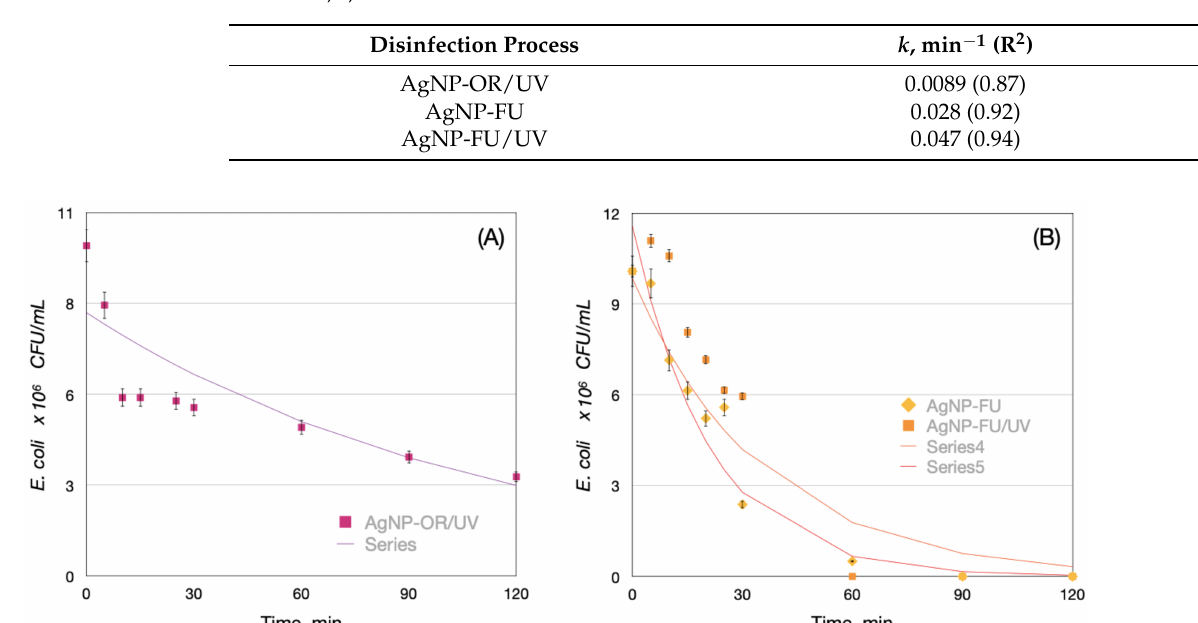
Table 1. Results of fitting the experimental antibacterial data to Chick’s law, in which the inactivation rate value, k , is shown.